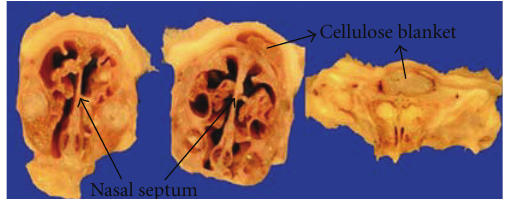
Figure 26: Serial cut from the nasal septum and front part of the nose showing the cellulose blanket in the nose bone structure.